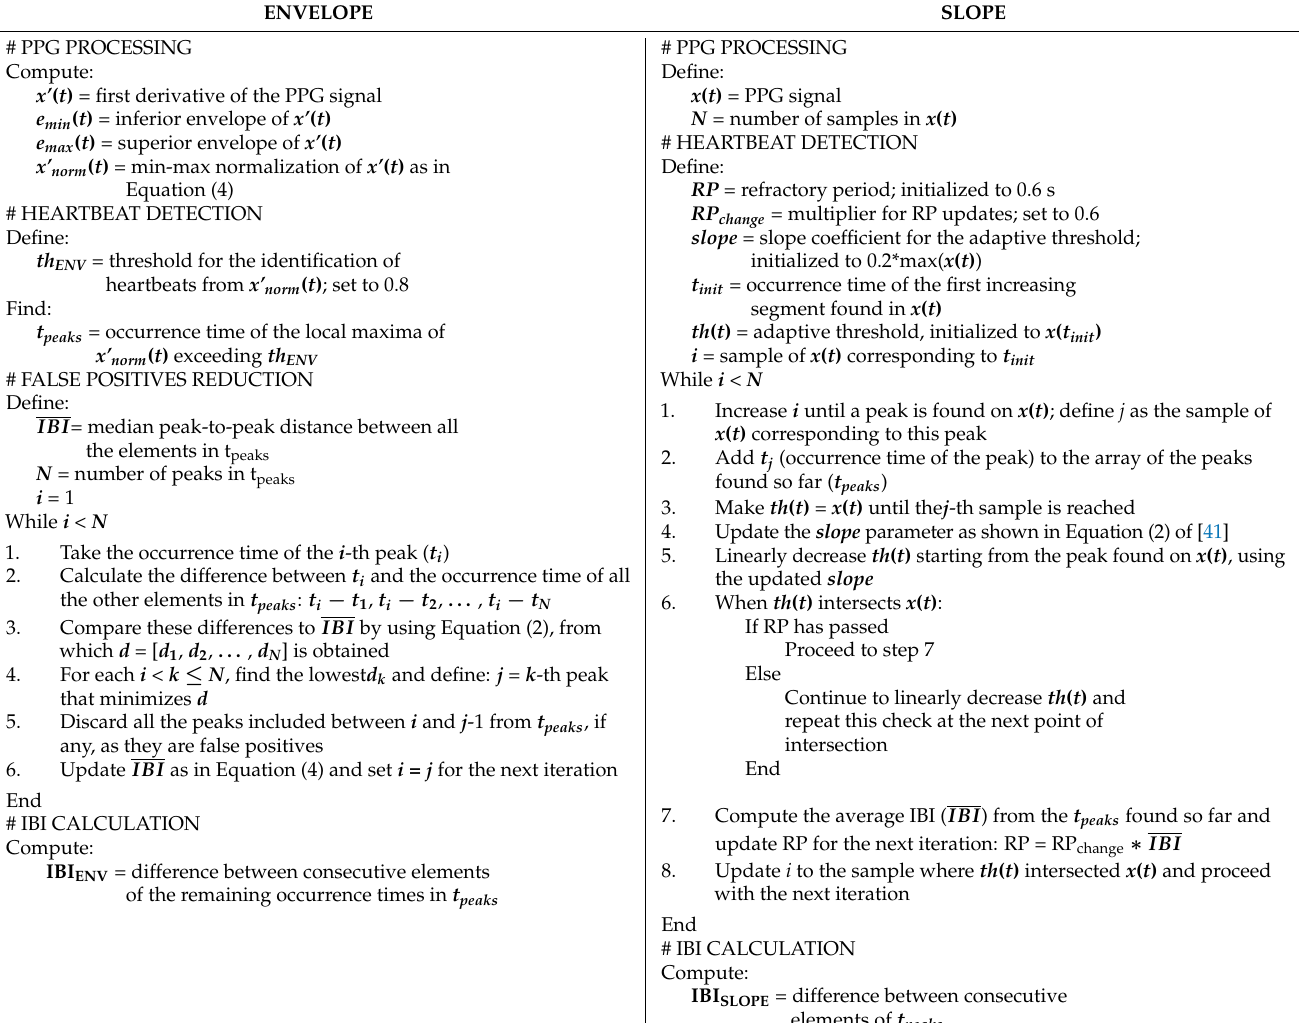
Table A1. Pseudo-code of the ENVELOPE and SLOPE beat detection algorithms. Bold type in variable names indicates